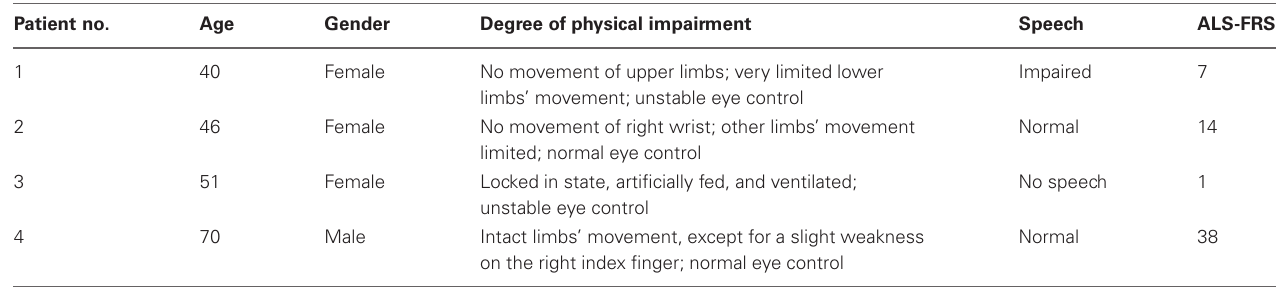
Table 1 | ALS patients’